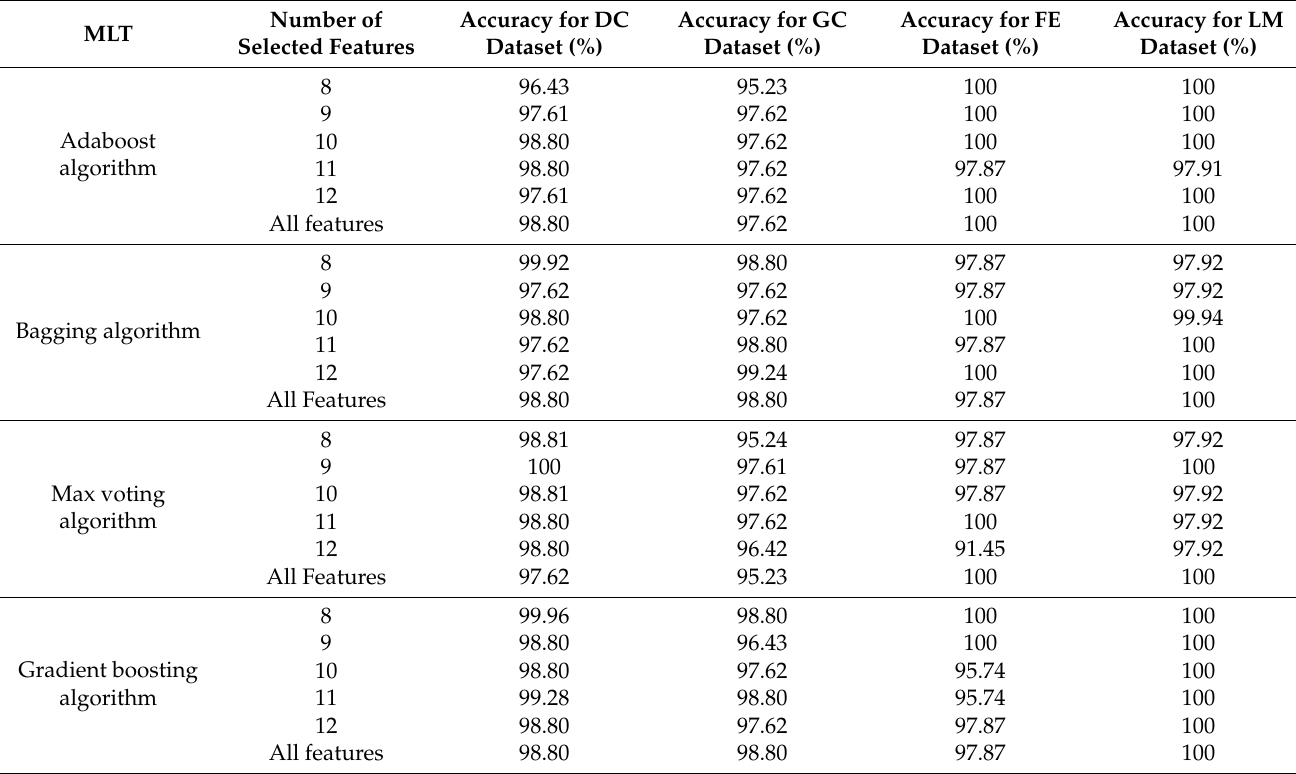
Table 13. Outcomes of Ensemble algorithms for different sets of selected